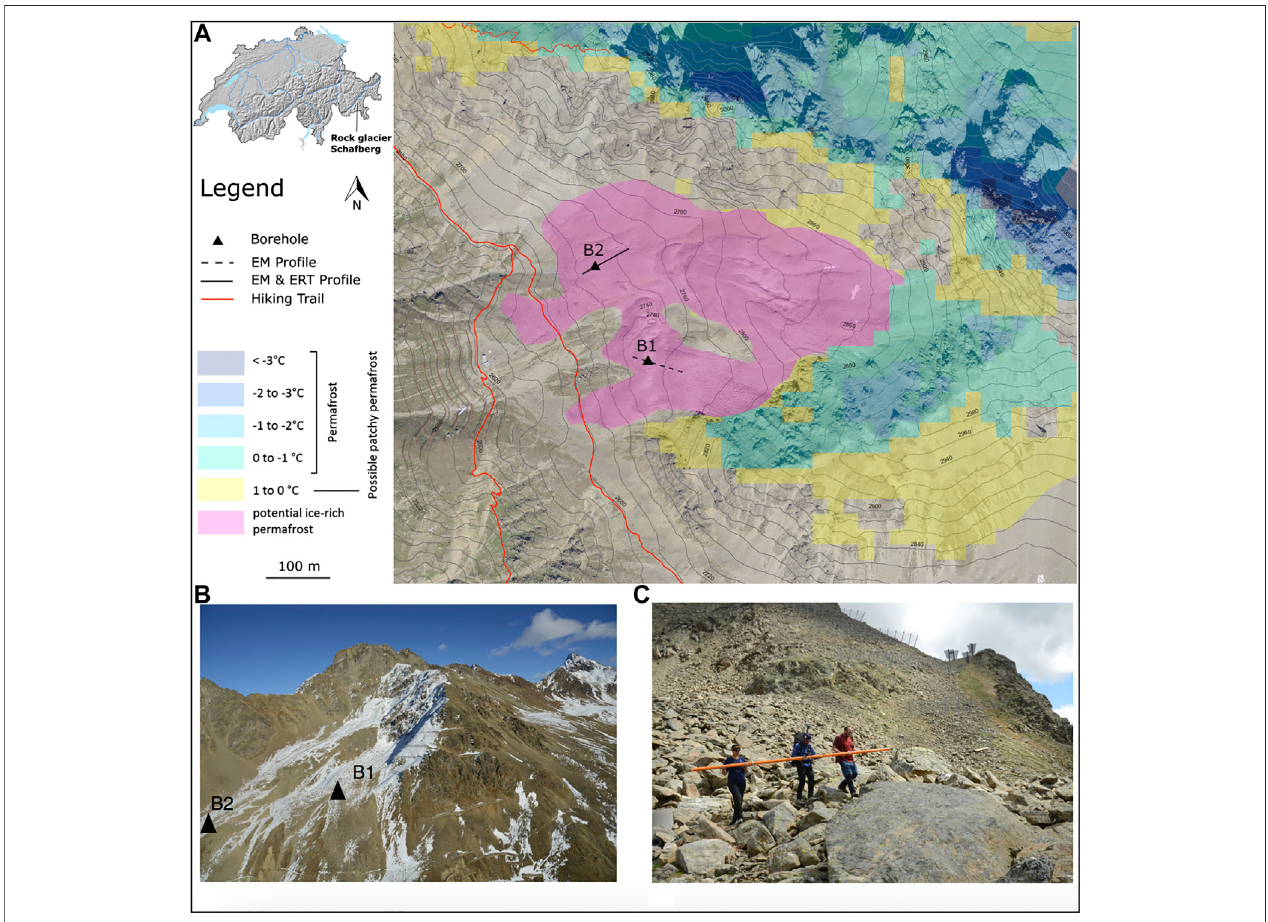
FIGURE 1 | (A) Modelled permafrost distribution (Kenner et al., 2019a) at the Schafberg site. The approximate extent of ice-rich permafrost is mainly based on photogrammetrical ground deformation measurements (Kenner et al., 2019b). (Aerial photograph: Swiss Federal Of fi ce of Topography swisstopo). (B) Overview of the Schafberg site (November 2015), with borehole locations B1 and B2. (C) Handheld Frequency Domain Electro-Magnetometry (FDEM) measurement next to borehole Schafberg B1 (July 30, 2019).